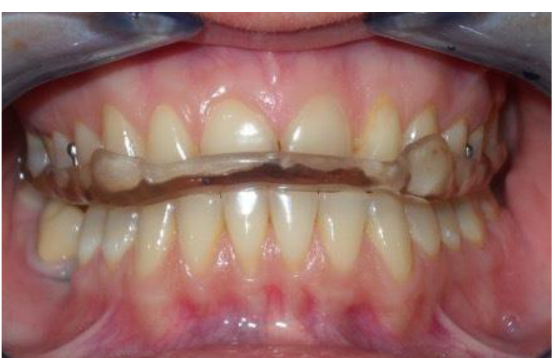
Figure 1. Stabilization splint. A RA.DI.CA. splint (Figure 2) is composed of: